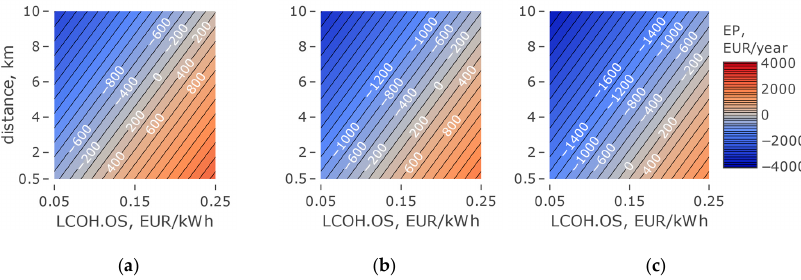
Figure 12. The Yearly Economical Profitable as a function of Levelized Cost of Heating from non- geothermal source (LCOH.OS) and distance between Geothermal Base Station and House, for Total Heat Demand (THD) = 10,000 kWh/year and for: ( a ) M-TES price = 2000 EUR; ( b ) M-TES price = 6000 EUR; ( c ) M-TES price = 10,000 EUR.